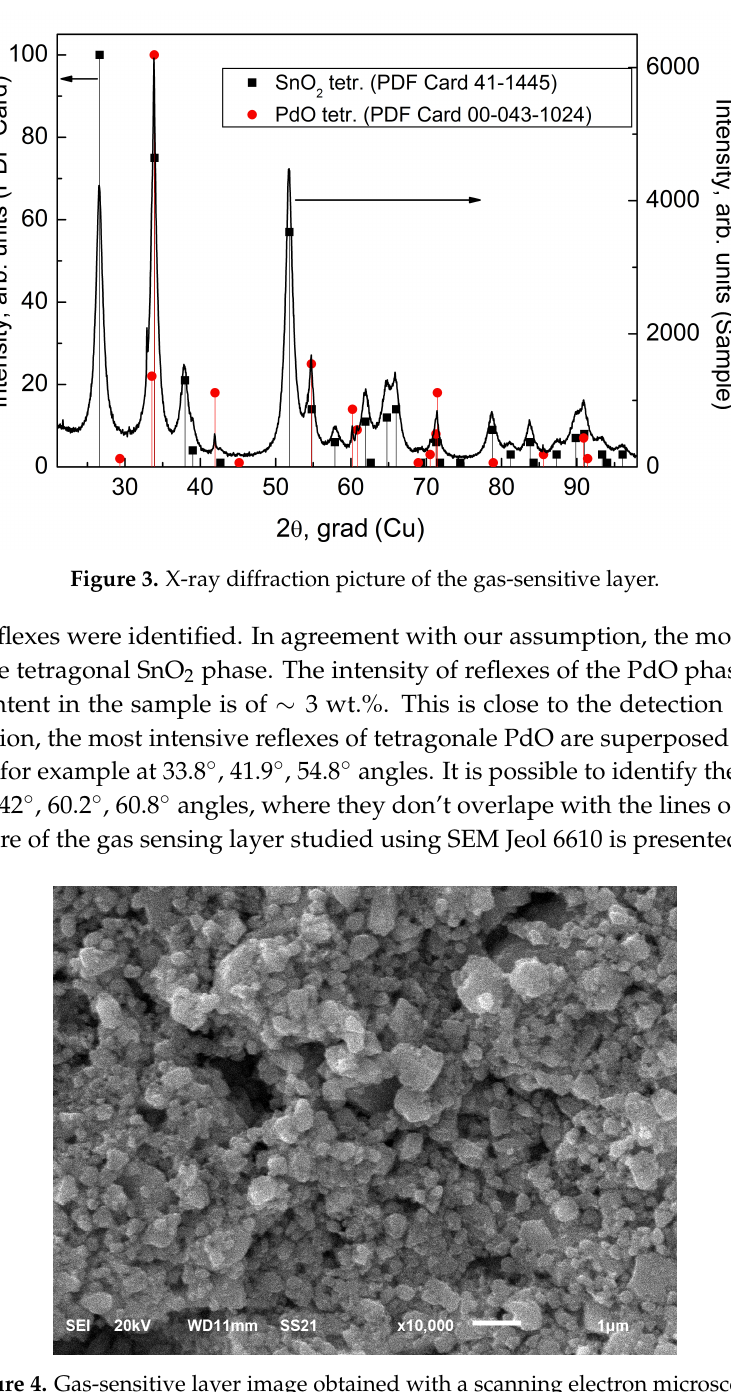
Figure 4. Gas-sensitive layer image obtained with a scanning electron